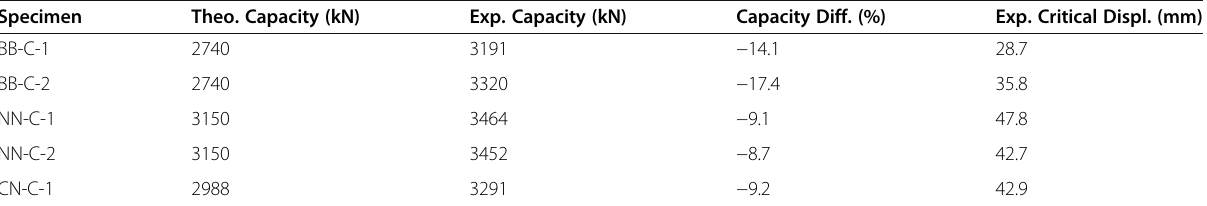
Table 4 Comparison of axial compressive capacity of control specimens using experimental results and theoretical capacity from Eq. (7)